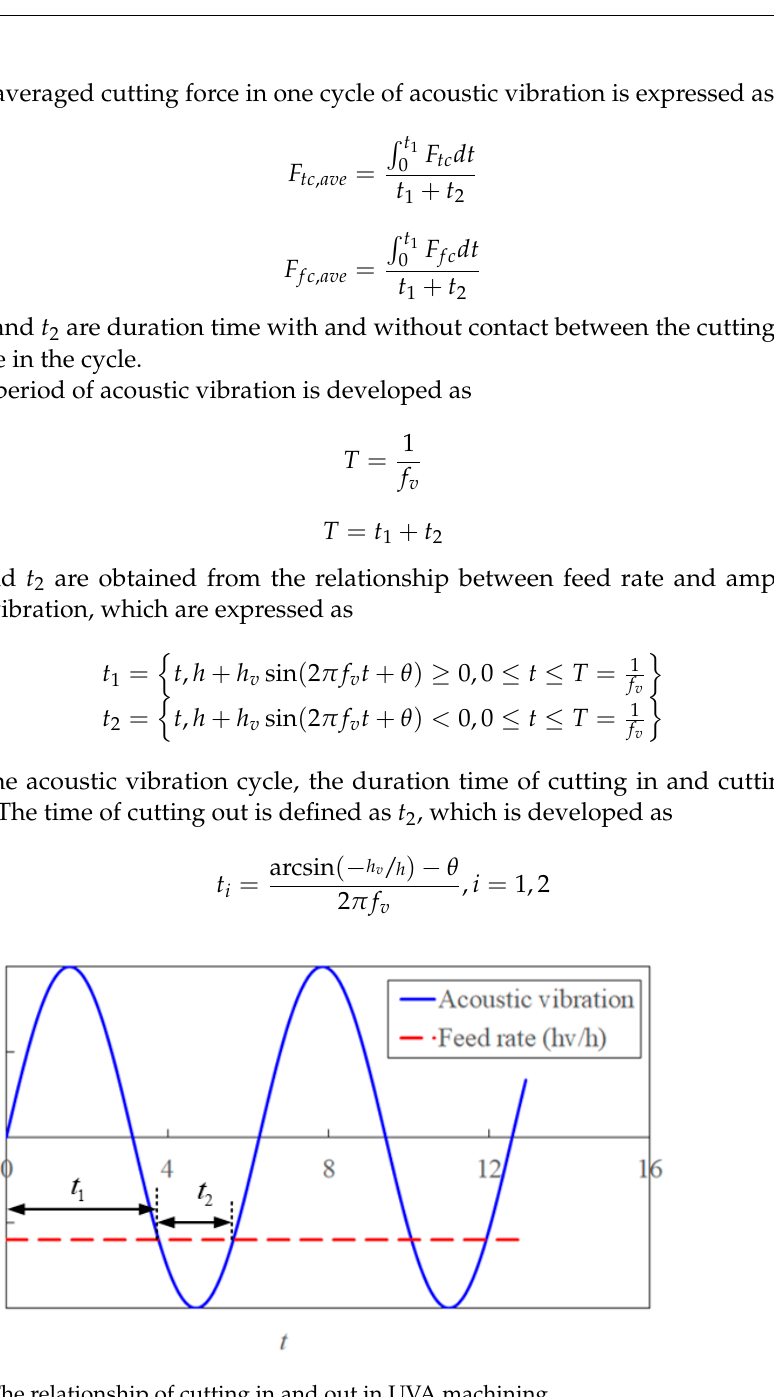
Figure 6. The relationship of cutting in and out in UVA machining.